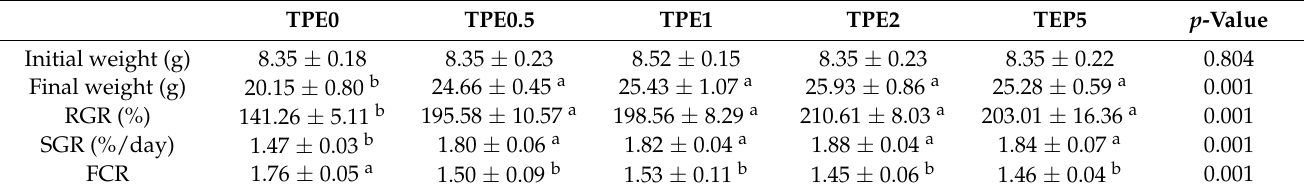
Table 3. Growth and feed utilization performance of common carp fed with experimental diets supplemented with different ratios of tomato paste by-product extract